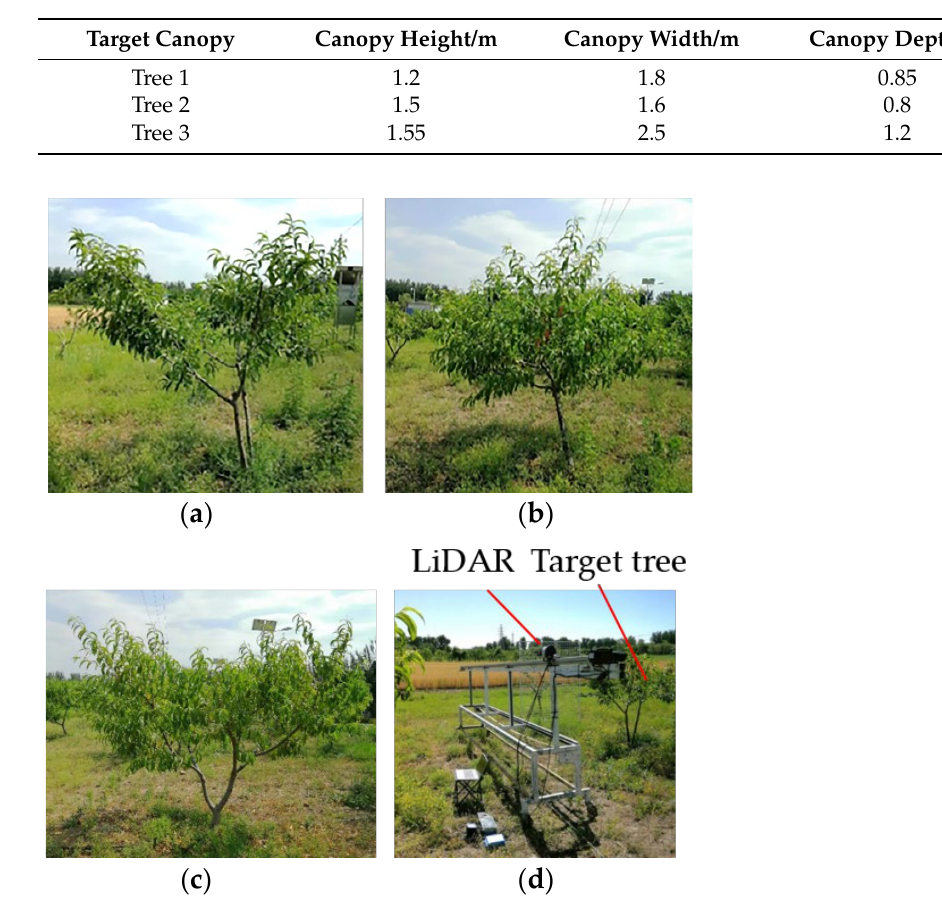
Table 2. Target canopy dimensions.